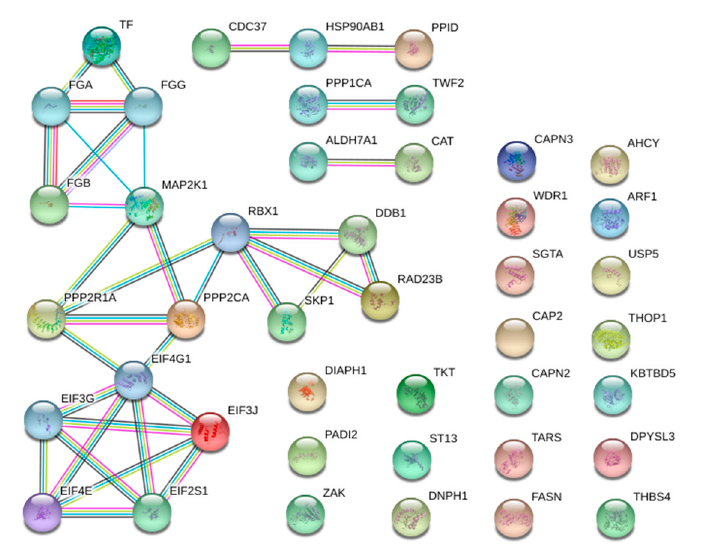
Figure 2. Protein–protein interaction (PPI) network of the proteins characterized between the Teramana and Saanen goat breeds generated with STRING software. Each node represents a protein, and different line colors represent the types of evidence for the association: cyan is from curated databases, magenta is experimentally determined, dark green is gene neighborhood, red is gene fusions, blue is gene co-occurrence, light green is textmining, black is coexpression and purple is protein homology.